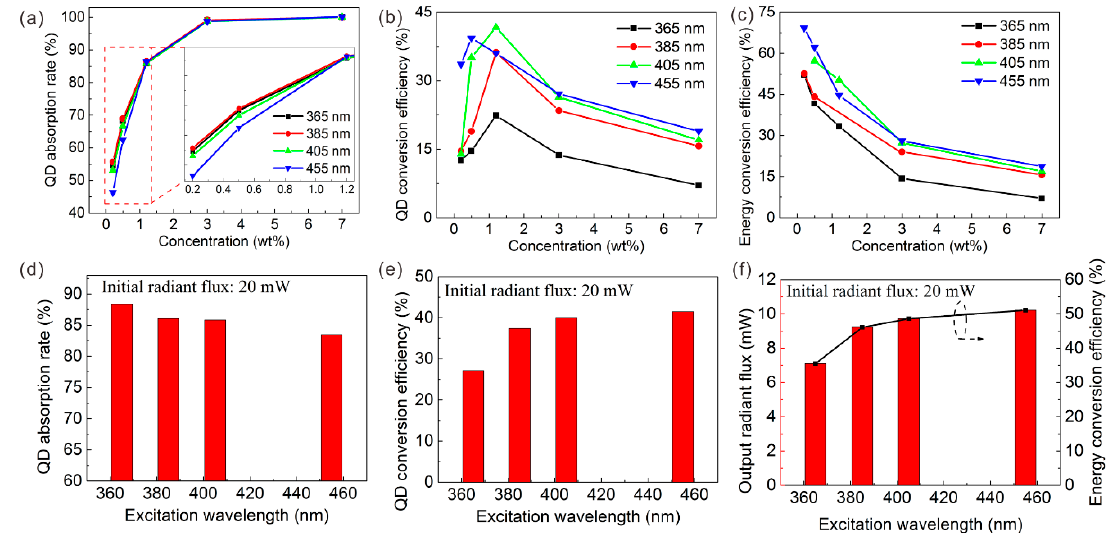
Figure 10. ( a , d ) QD absorption rate, ( b , e ) QD conversion efficiency, and ( c , f ) energy conversion efficiency of GQD LED with different excitation wavelengths.